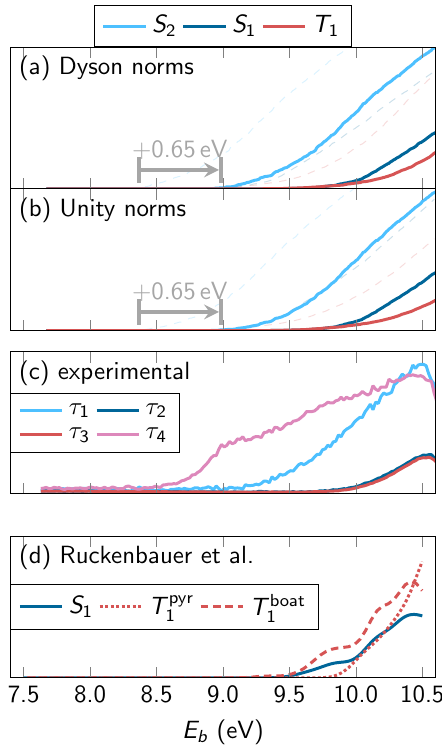
Figure 5. In ( a , b ), we show the simulated photoelectron spectra of each electronic state, computed by integrating over the whole simulation time, for Dyson norms and unity norms, respectively. For better comparison, each spectrum is normalized by the time-averaged population of each state and shifted by +0.65 eV to higher binding energies (the unshifted spectra are shown as thin, dashed lines). In ( c ), we show the experimental decay-associated spectra (DAS) for the four fitted time constants τ 1 to τ 4 . The coloring of the four DAS was done in line with the assignment of τ 1 to S 2 S 0 . In panel ( d ), we also show the predicted ionization spectra of the vibrationally cold S 1 and to T → T 1 minima from Ref.